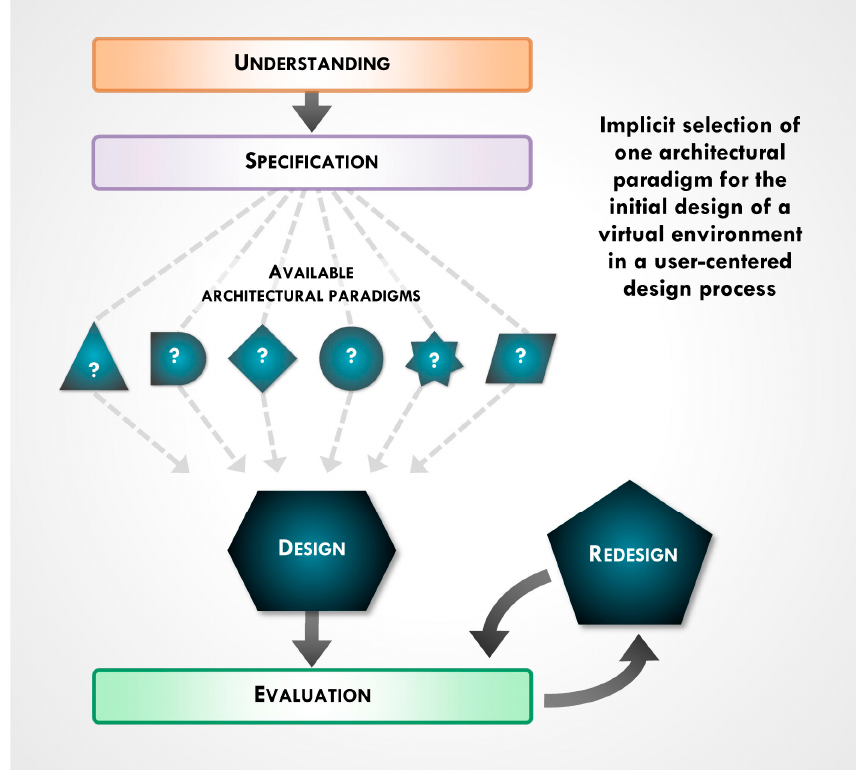
Figure 2. Creation of the initial design for a virtual environment often involves the unconscious choice of a particular architectural paradigm. of a particular architectural